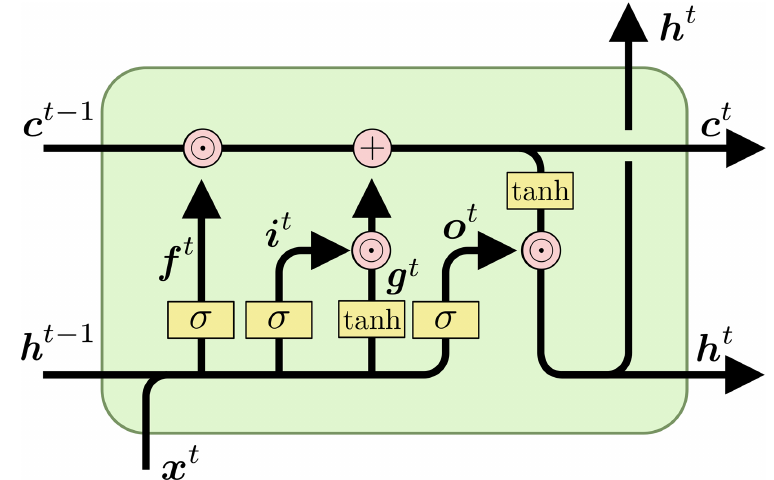
Figure A1. A single time step of a standard LSTM, with time steps marked as superscripts for clarity. x t , c t , and h t are the input features, cell states, and recurrent inputs at time t , respectively. f t , i t , and o t are the respective forget gates, input gates, and output gates, and g t denotes the cell input. Boxes labeled σ and tanh represent respective single sigmoid and hyperbolic tangent activation layers with the same number of nodes as cell states. The addition sign represents element-wise addition, and (cid:12) represents element-wise